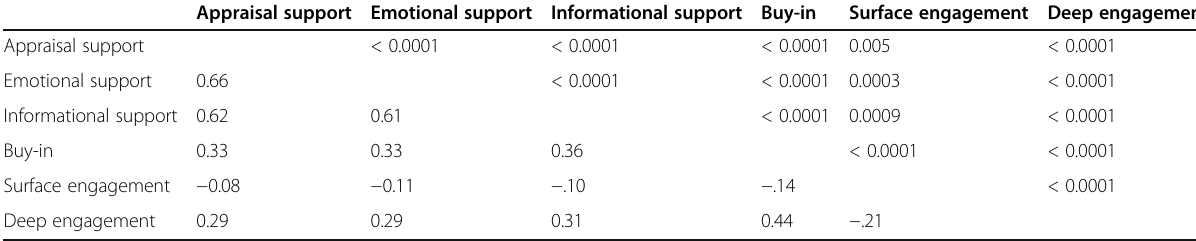
Table 4 Kendall rank coefficient correlations between appraisal, emotional, and informational support and three measures of engagement: buy-in, surface engagement, and deep